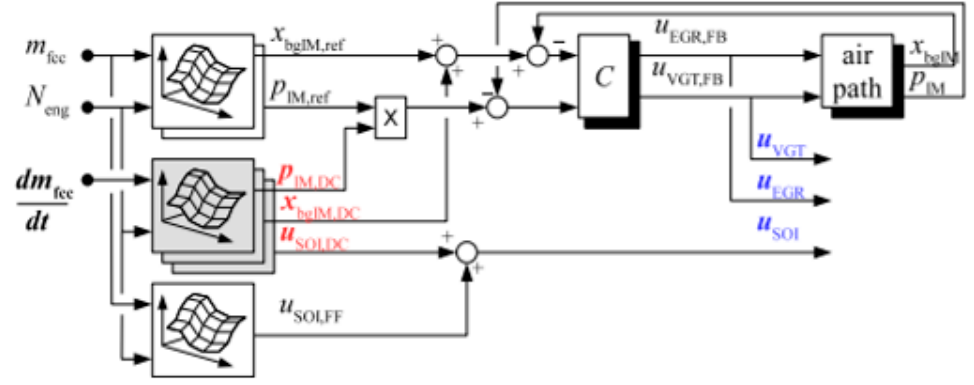
Figure 16. Feedback (FB) control of the state variable set-point maps.